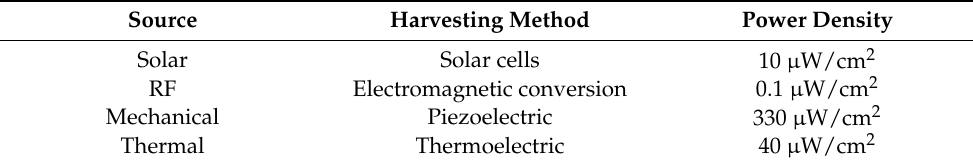
Figure 1. Thermoelectric harvesting energy from waste heat [11]. Table 1. Power densities of different energy harvesting sources. Table 1. Power densities of different energy harvesting